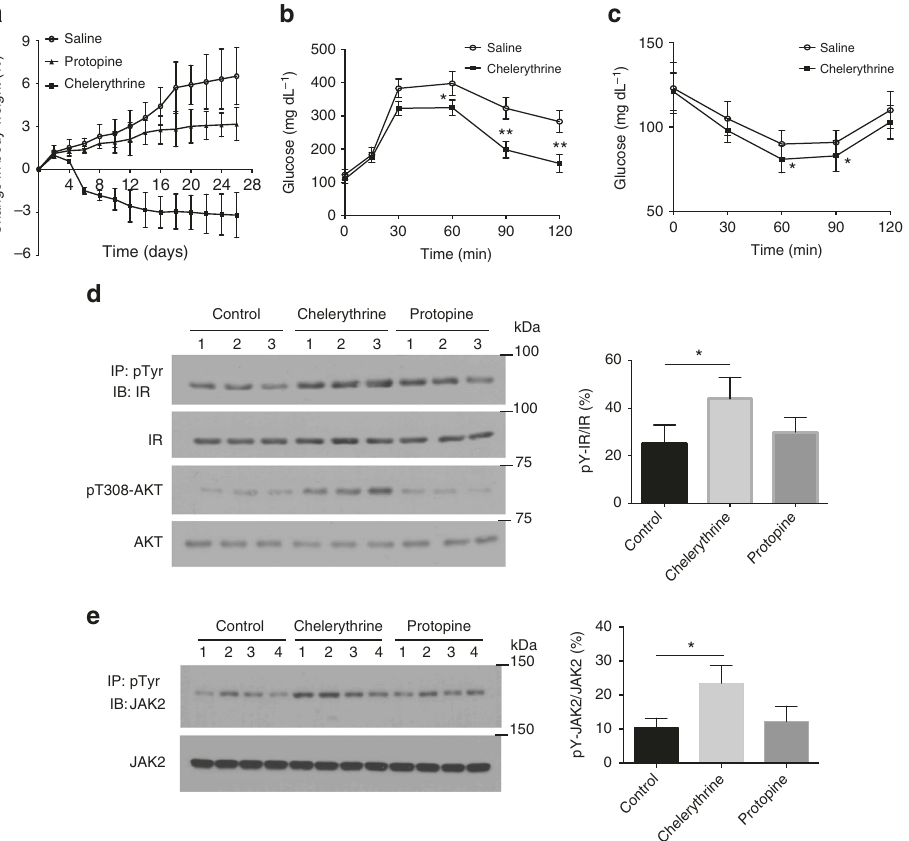
Fig. 9 Chelerythrine improved metabolism and promoted insulin and leptin signaling in mice. a Body weight of male mice (C57bl6/J) fed high fat diet and treated with chelerythrine (3 mg kg − 1 ), protopine (3 mg kg − 1 ) or saline was monitored from the beginning of the treatment (10 weeks of age) until the study was terminated (14 weeks of age). Data represent the mean ± s.e.m. ( n = 10 in each group). b HFD fed 14-week-old male mice treated with saline or chelerythrine were administered D -glucose (2 mg g − 1 body weight), and blood glucose was monitored over the de fi ned time. Data represent the mean ± s.e. m. ( n = 10 in each group) and statistical analysis was performed using two-way ANOVA (* p < 0.05, ** p < 0.01). c HFD fed 14-week-old male mice treated with saline or chelerythrine were administered insulin (0.75 mU g − 1 body weight), and blood glucose was monitored over the de fi ned time. Data represent mean ± s.e.m. ( n = 10 in each group) and statistical analysis was performed using two-way ANOVA (* p < 0.05). d Representative immunoblots showing week-old male mice treated with saline, chelerythrine or protopine. For insulin stimulation, animals were treated with insulin (0.75 mU g − 1 , i.p.) for 15 min. e lysates from 14-week-old male mice treated with saline, chelerythrine or protopine. For leptin stimulation, animals were treated with leptin (1 mg kg − 1 , s.c.) for 15 min. All immunoblots are representative of tissue lysates generated from at least three independent animals for each condition ( n = 3). Immunoblots were quanti fi ed using ImageJ software. Quantitation includes all independent data from the respective experiments and is presented as the mean ± s.e.m. d , e Statistical analysis was performed using two-way ANOVA (* p <